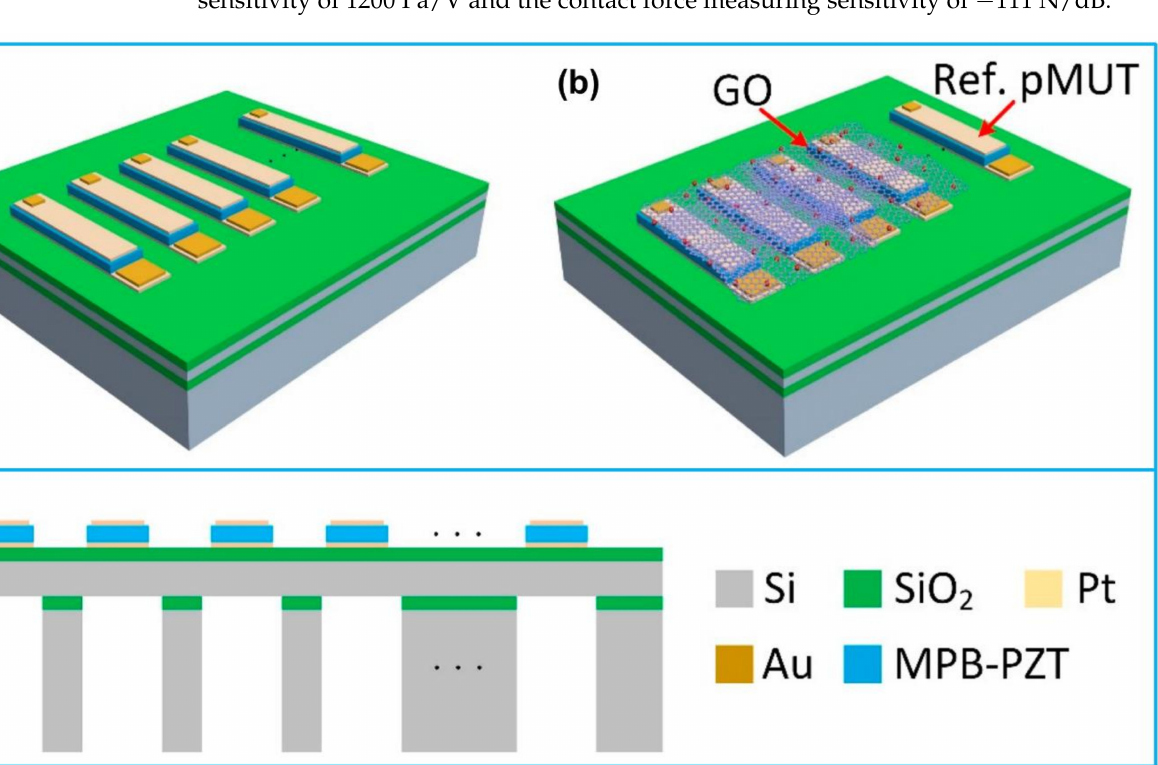
Figure 9. A PMUT array for humidity sensing. ( a ) The PMUT array; ( b ) the PMUT-based humidity sensor; ( c ) cross-sectional view of the PMUT array. Reprinted from Ref. [149] with